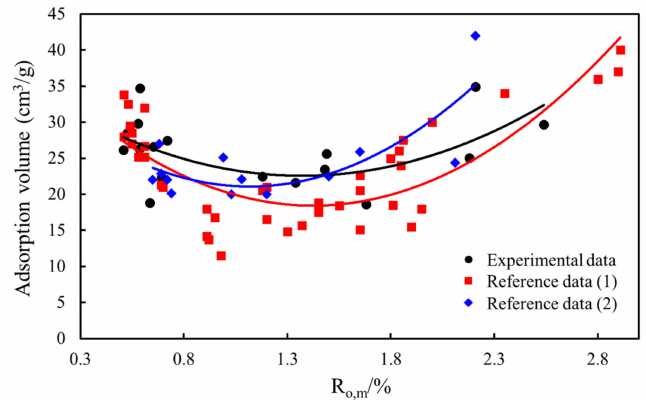
Figure 11. Relationship between adsorption amount and coal rank (Reference data (1) quoted from